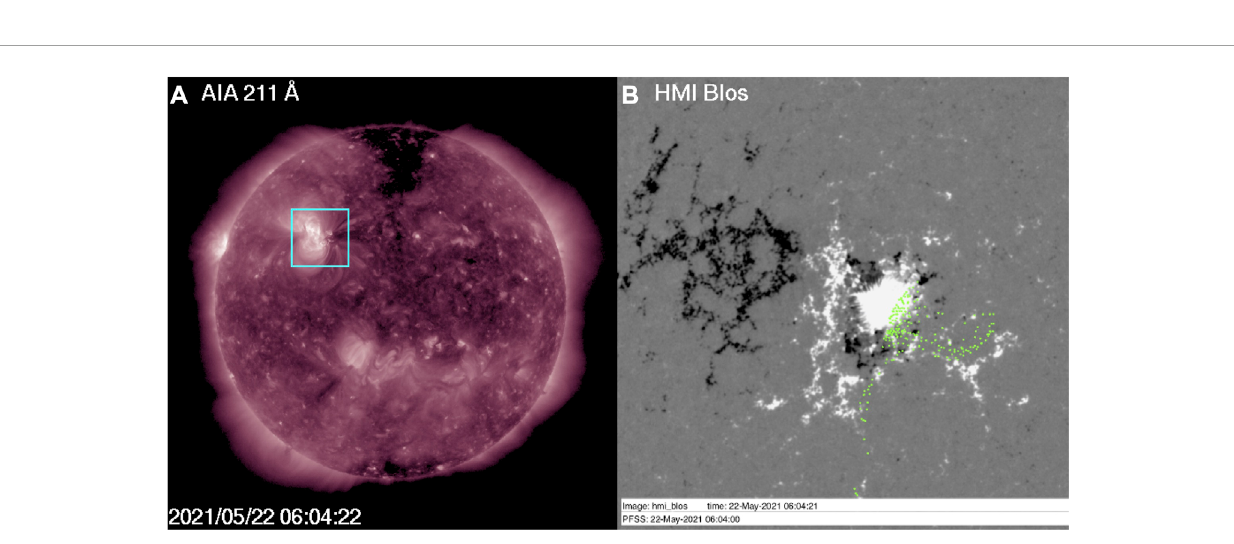
FIGURE 3 (A) AIA 211 Å image on 22 May 2021. AR 12824 was within the cyan box. (B) HMI line-of-sight magnetogram of the region marked by the cyan box in (A) . Green dots show the footpoints of open field lines as calculated using the PFSS model.